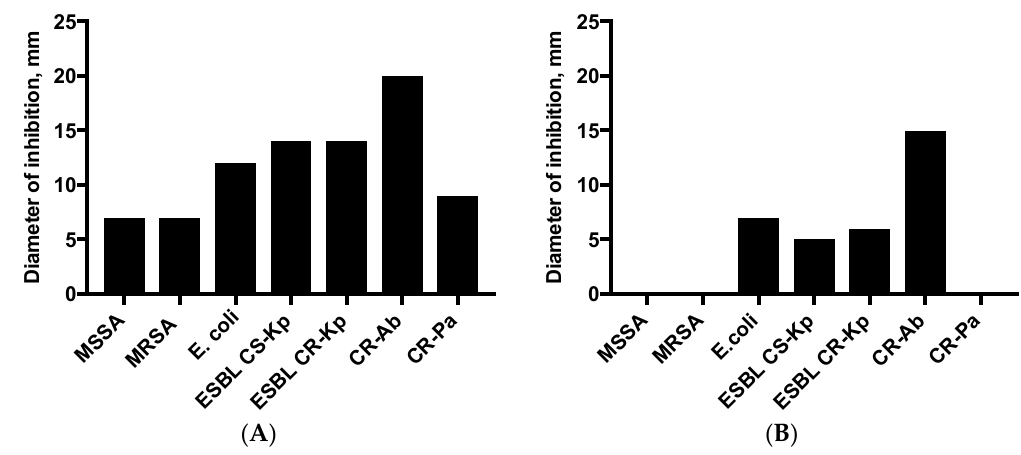
Figure 1. Disk diffusion ( panel A ) and vapor phase ( panel B ) activity of TTO. MSSA: Methicillin-susceptibility Staphylococcus aureus ; MRSA: Methicillin-resistant Staphylococcus aureus ; ESBL: Extended Spectrum Beta-Lactamases; CS: Carbapenem-Susceptible; CR: Carbapenem-Resistant; Kp: Klebsiella pneumoniae ; Ab: Acinetobacter baumannii ; Pa: Pseudomonas aeruginosa .